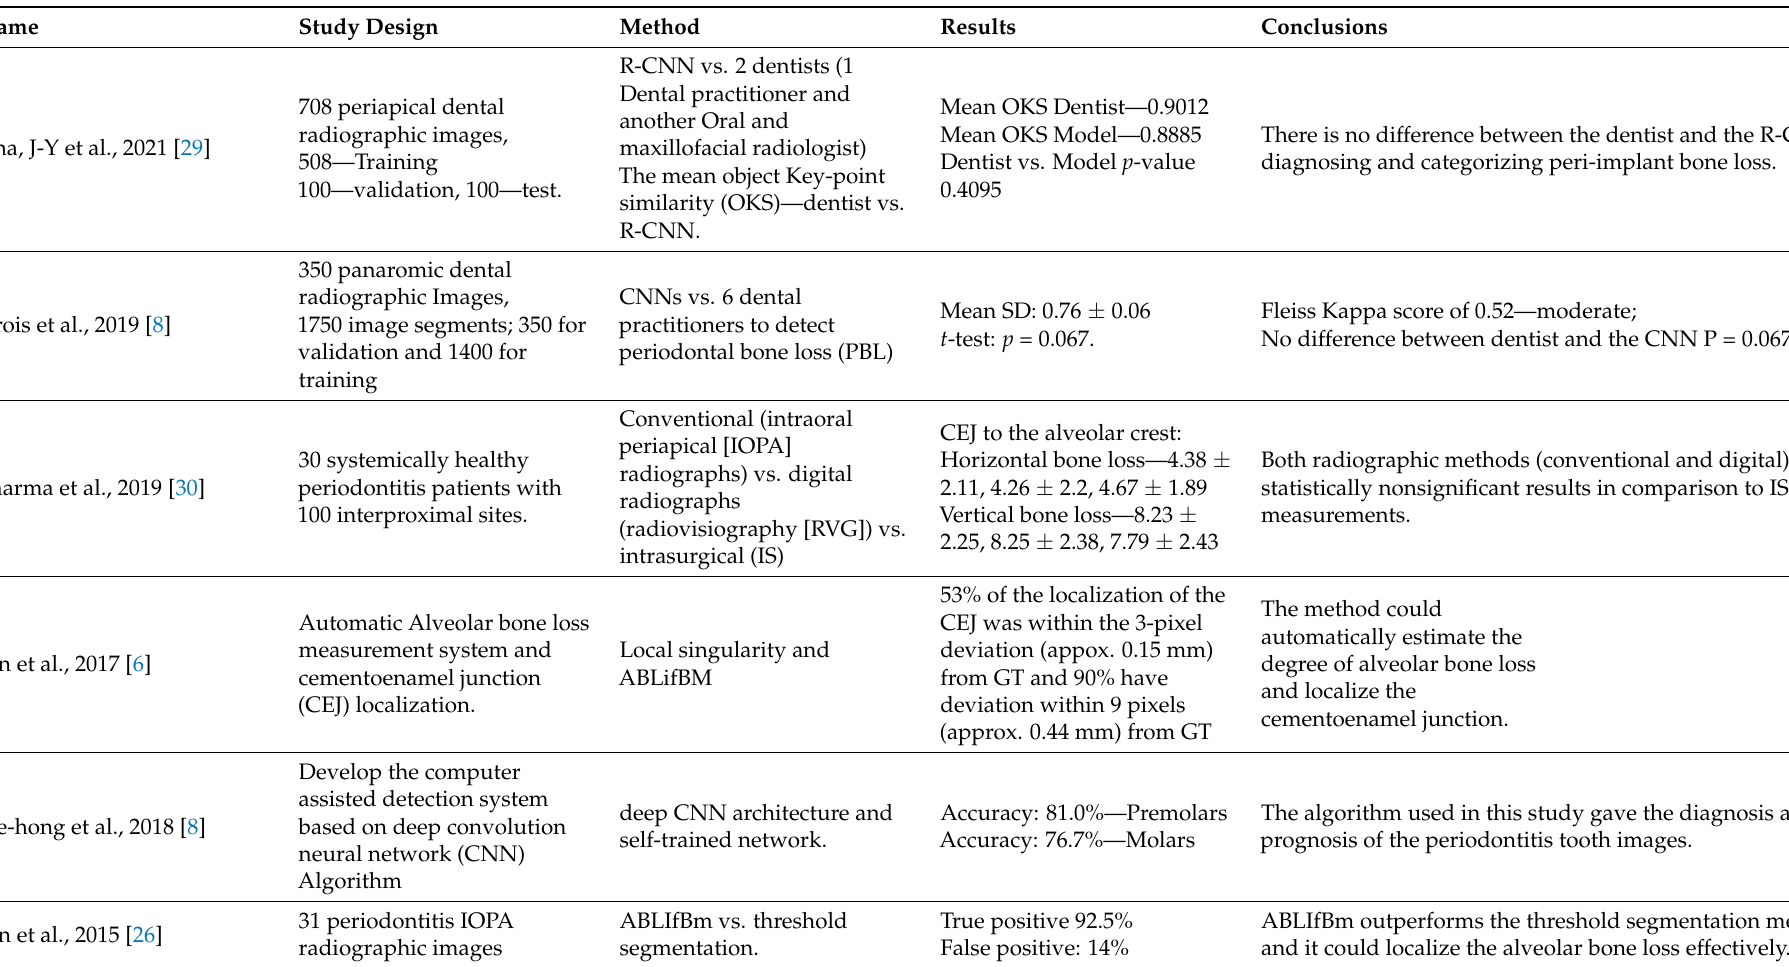
Table 5. Various studies showing the estimation of alveolar bone loss using different